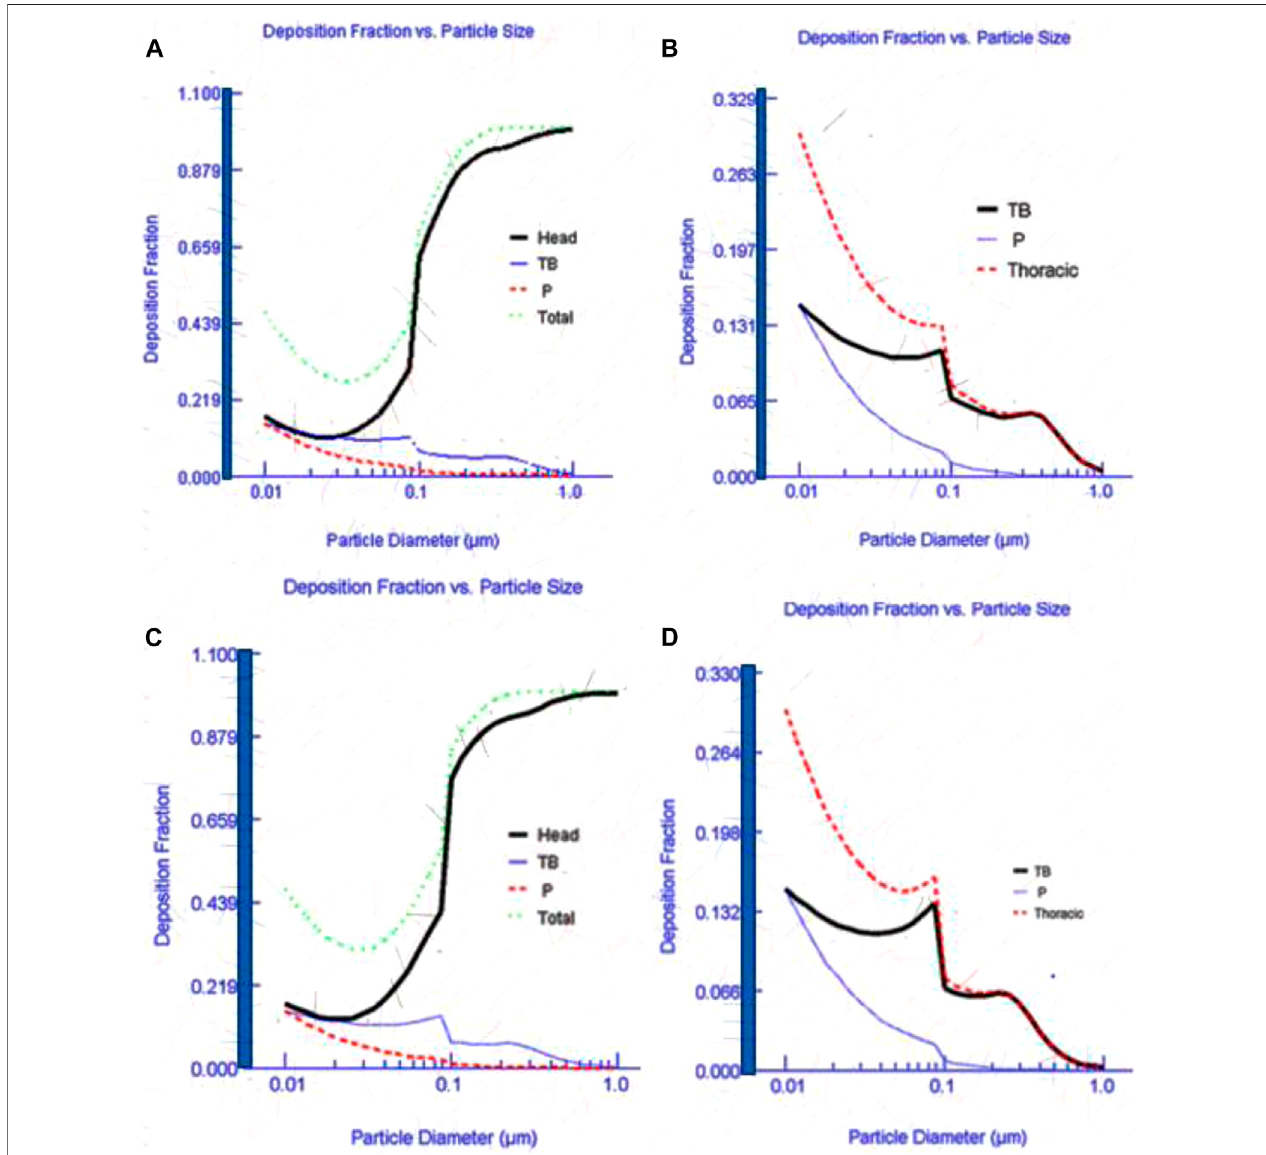
FIGURE 5 | Deposition fraction of Au (A – B) and Ag (C – D) nanoparticles in a simulated human respiratory system.